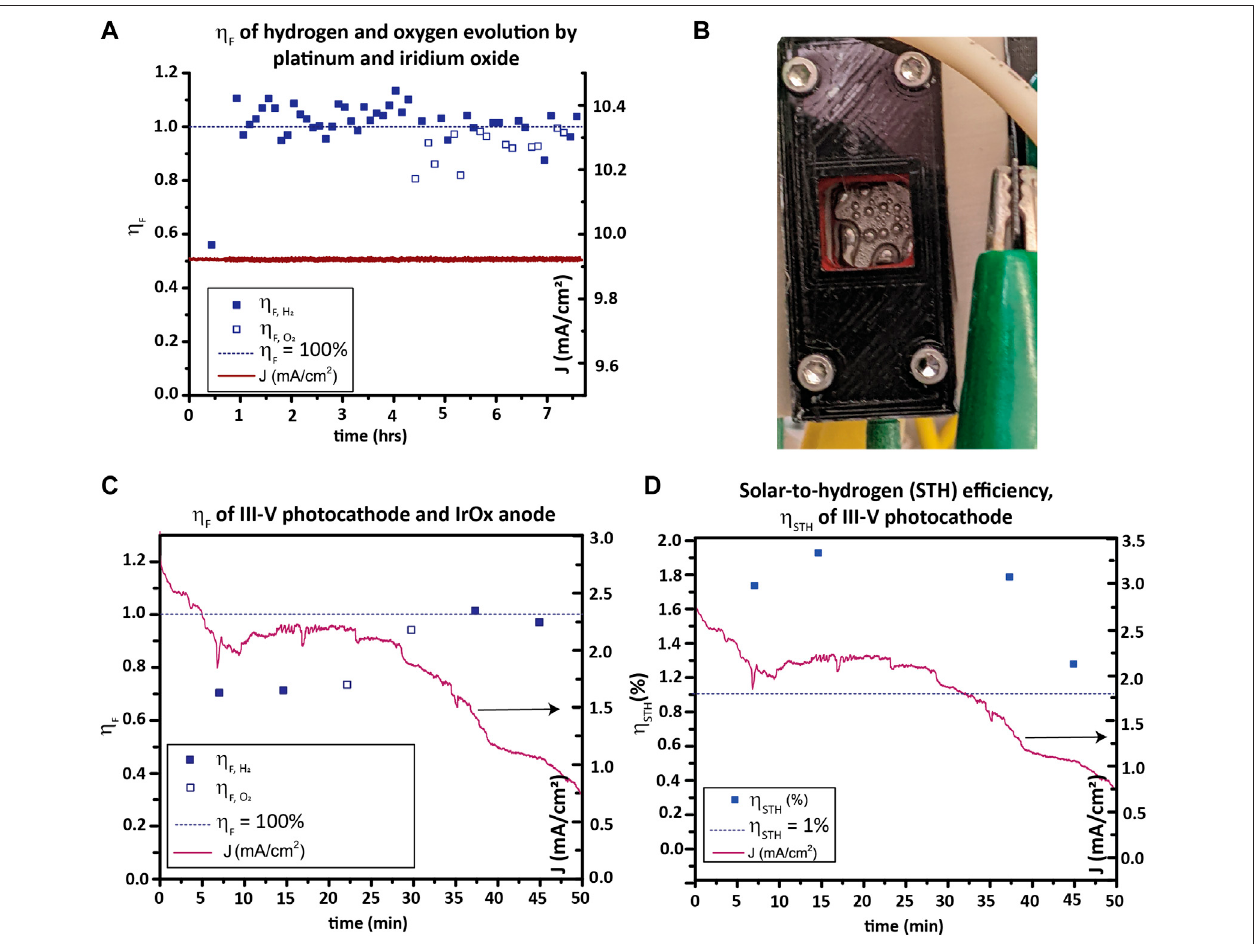
FIGURE 15 | η F and η STH . (A) Hydrogen and oxygen evolution faradaic ef fi ciency ( η F ) of a Pt WE and IrO x CE in 0.5 M H 2 SO 4 over 7 h. Average measured η F is 103% +/ − 5% for HER and 93% +/ − 6% for OER, with likely sources of loss being minor system leaks and minor crossover and recombination. (B) Hydrogen evolution from a Pt foil electrode in the test vessel during the η F measurement in (A) . (C) H 2 and O 2 η F of a GaInP/GaAs photocathode and IrO x anode in a two-electrode CA measurement. (D) η STH calculated from (C)